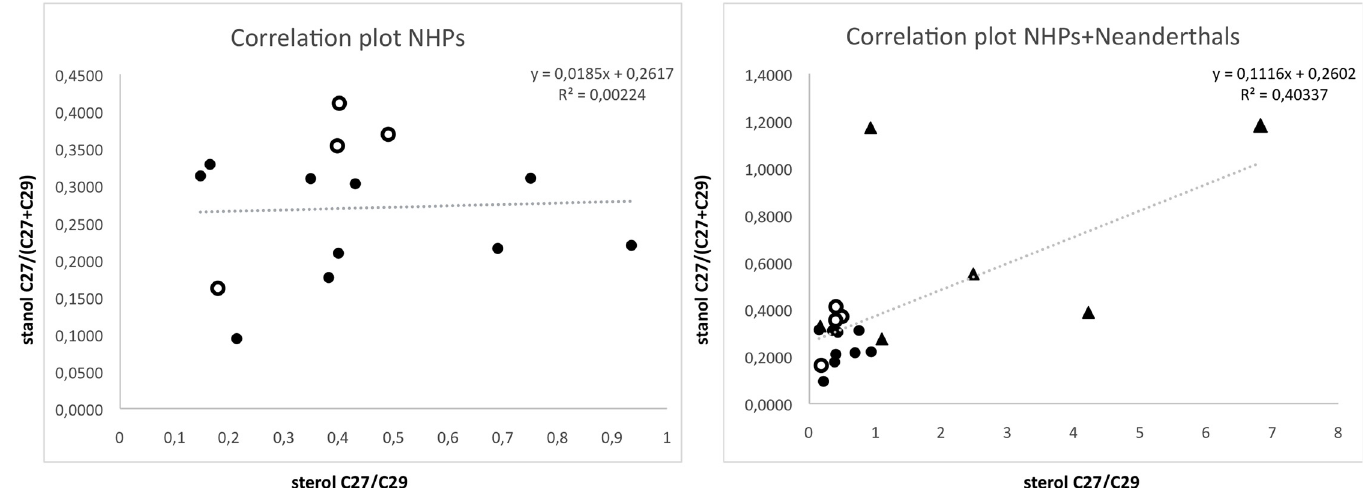
Fig 3. Correlation plot. Two correlation plots are presented. The first shows the correlation between the 5 β -stanol ratio C27/(C27+C29) (Y axis) and the sterol ratio C27/C29 (X axis) in the NHP samples. Given that C29 stanols were not present in some samples we have applied the 5 β -stanol ratio C27/(C27 +C29) instead of the ratio stanol C27/C29 [65]. Gorillas are shown as white circles. The second plot shows the same correlation but including Neanderthal samples